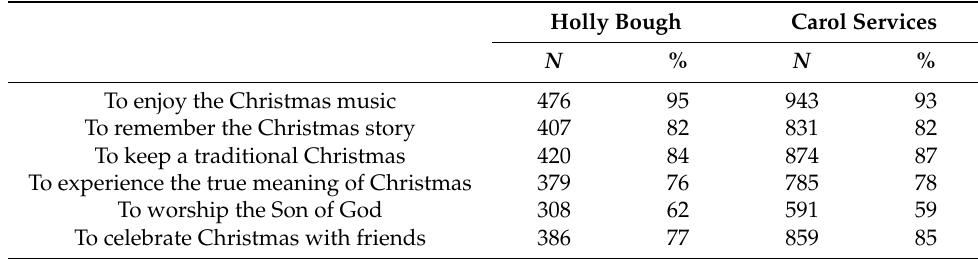
Table 12. Motivation for